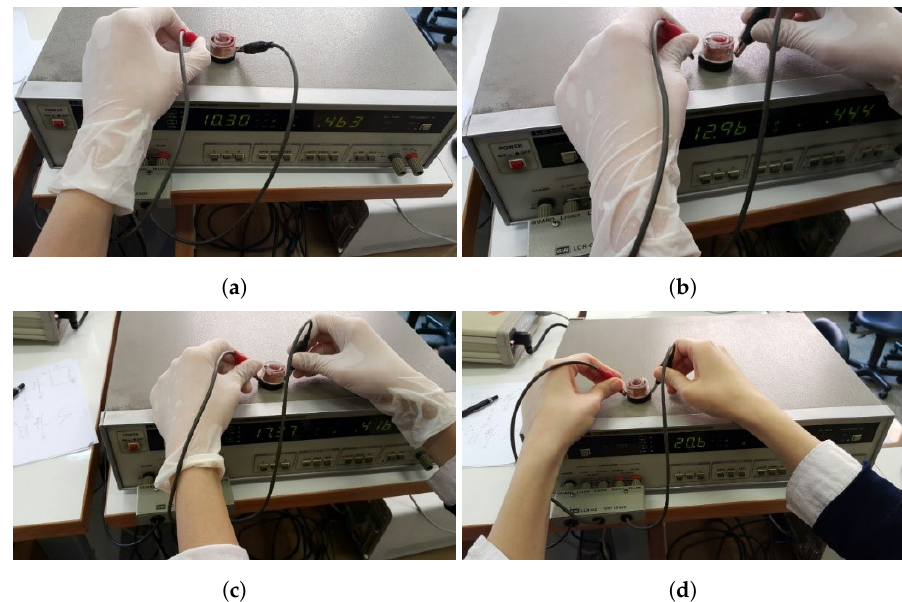
Figure 2. Capacitance measurement of a cancerous blood sample (Sample #7 in Table 1; note the values on the screen). ( a ) At the start time of the experiment; ( b ) after 5 min; ( c ) after 10 min; ( d ); after 15 min and later on. Table 1. Capacitance values of the studied blood samples alongside with their blood factors extracted from the complete blood count (CBC) test. The asterisk besides the sample numbers indicates the samples with acute lymphatic leukemia (ALL). Legend: #: sample number, A: cancerous sample